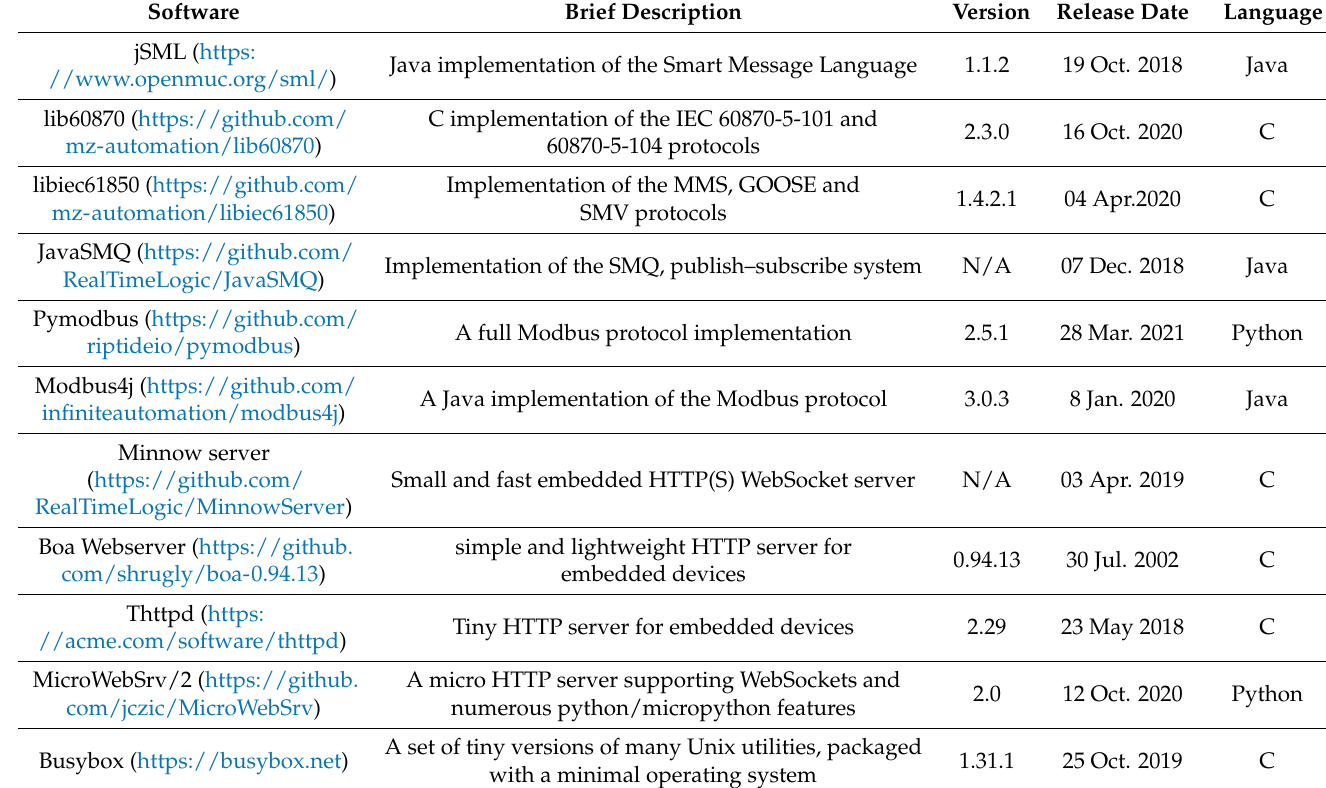
Table 1. Software projects used in the